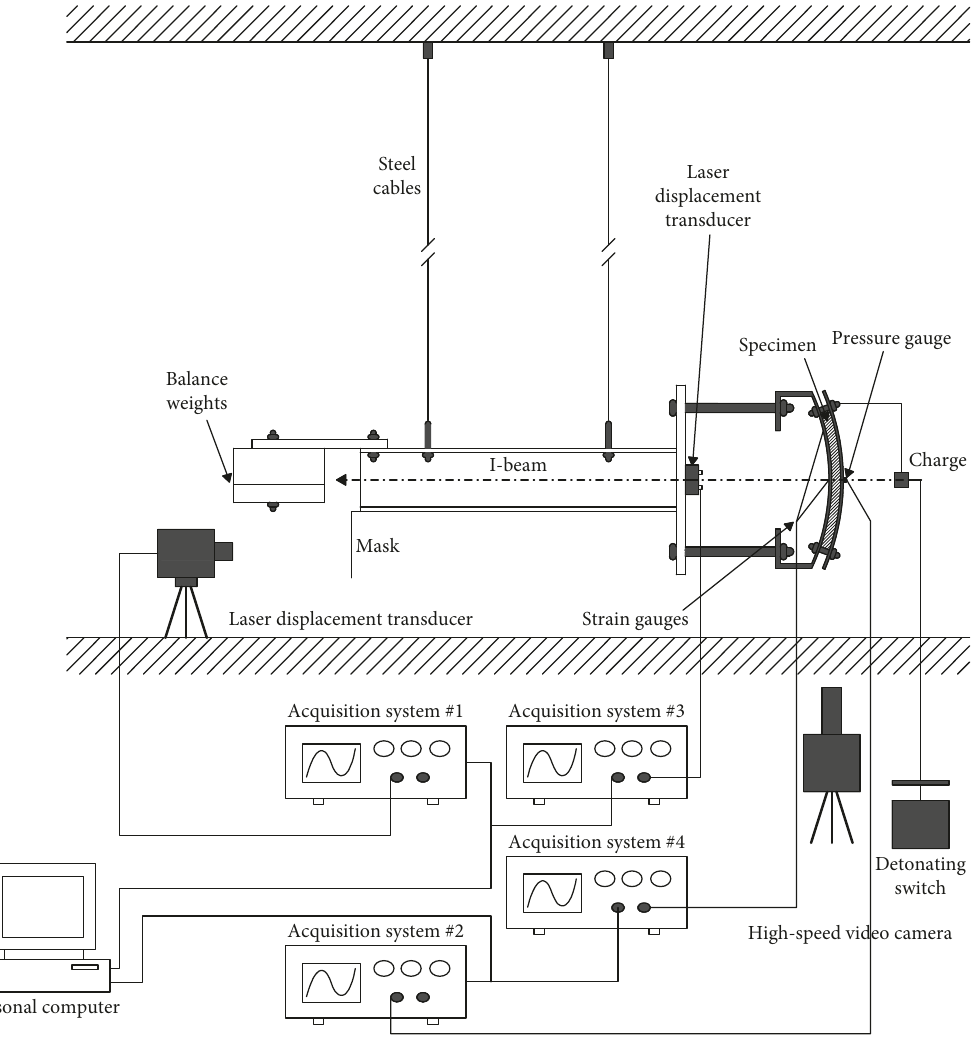
Figure 4: Ballistic pendulum experimental setup [57].